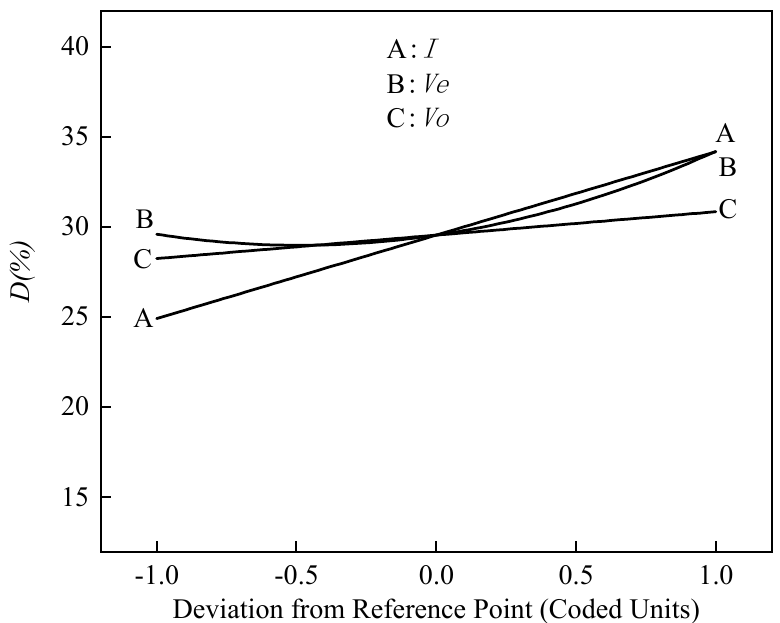
Figure 3. Dilution-rate perturbation graph. Figure 3. Dilution - rate perturbation graph. Figure 3. Dilution - rate perturbation graph.